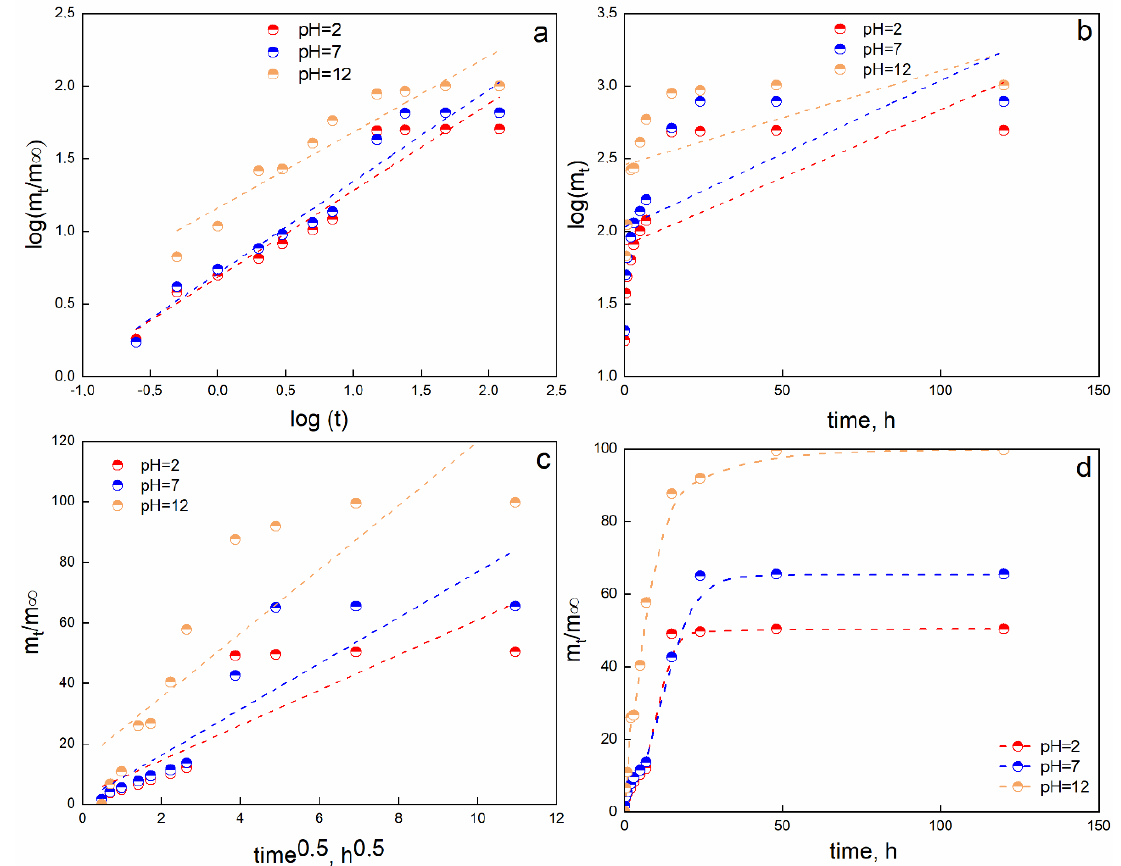
Figure 6. Release data fitted through Korsmeyer–Peppas ( a ), first-order ( b ), Higuchi ( c ) and modified Weibull ( d ) models.